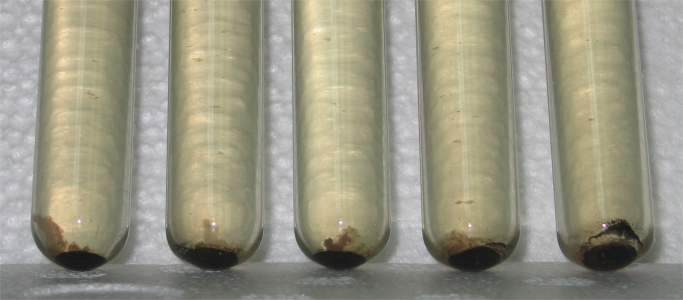
S. olleyana grown at 4–10 °C on Zobell׳s marine broth. Black precipitates formed at the bottom of the culture tubes after 48 h incubation.